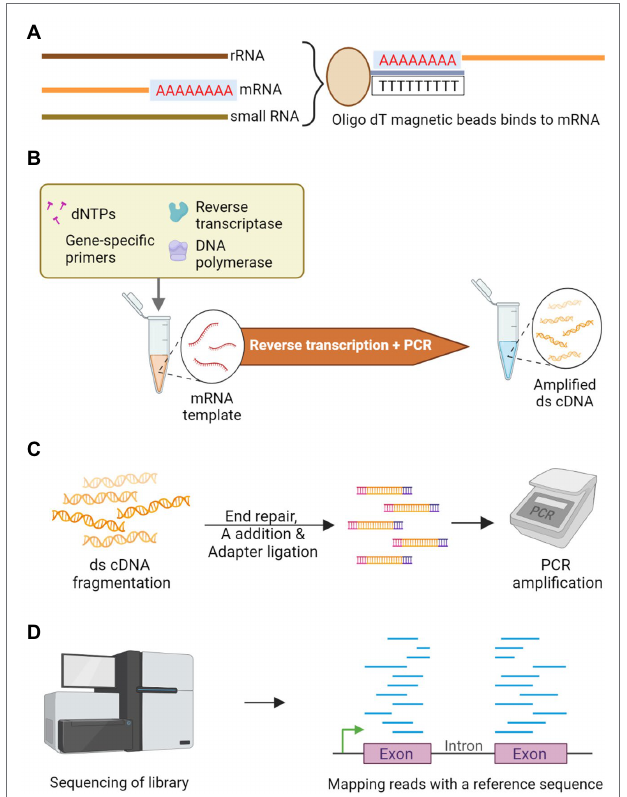
FIGURE 4 | Schematic representation of RNA-Seq to sequence the transcriptome. (A) Poly A tailed messenger RNA (mRNA) is isolated among other RNA types using oligo dT magnetic beads. (B) Double-stranded complementary DNA (cDNA) library is constructed by employing reverse transcriptase on the isolated mRNA. (C) Enzymatic fragmentation of double- stranded cDNA is carried out to construct uniform library followed by end repair and an A nucleotide is added-to facilitate adapter ligation. These fragments are subjected to PCR amplification. (D) The amplicons are sequenced and differentially expressed genes are identified by mapping the reads with a quality reference sequence comparing the contrasting genotypes.